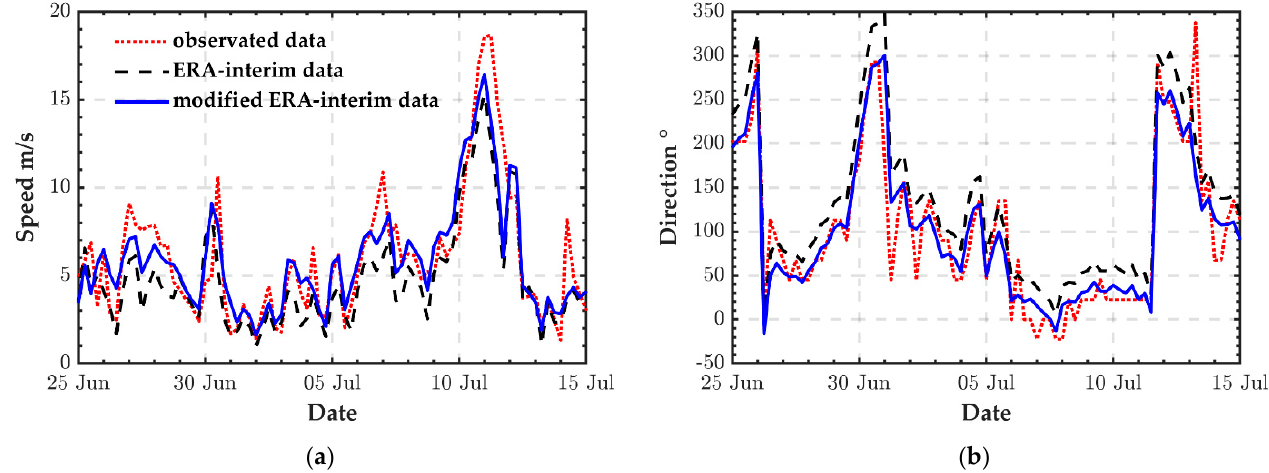
Figure 10. Comparisons between the ERA-interim, modified ERA-interim, and observational data of wind speed ( a ) and wind direction ( b ) in July 2015.